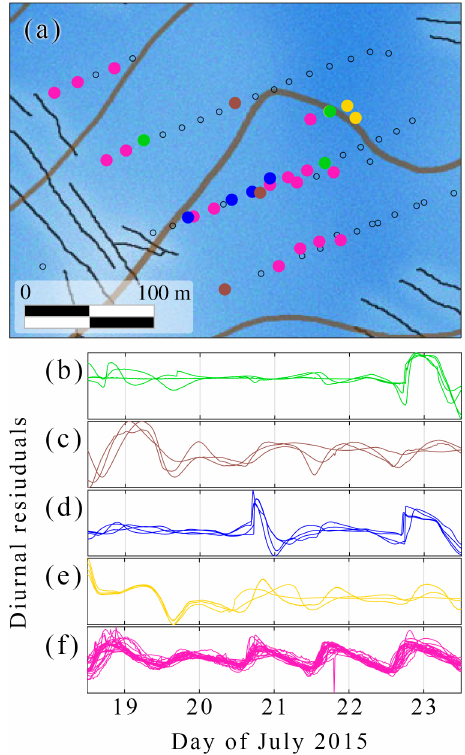
Figure 18. Detailed spatial distribution (a) and diurnal residuals (b– f) of five clusters observed in the plateau area between 18 and 23 July 2015. Only correlated boreholes are